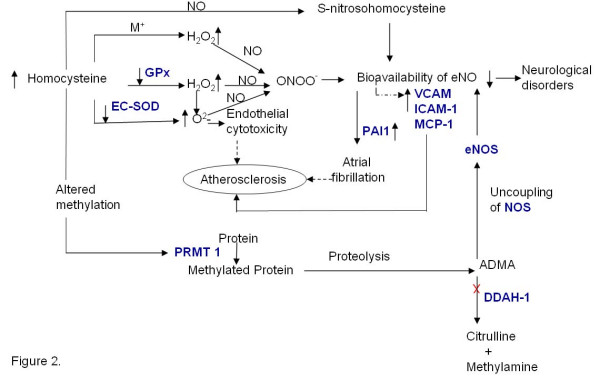
Hyperhomocysteinemia and Oxidative Stress. Homocysteine might directly or indirectly lead to oxidative stress via the pathways shown in the figure. The genes marked in blue have been identified by literature based searches as mentioned in the methods section. The solid and dotted lines indicate direct and indirect (multi step) interaction/ conversion respectively. X – Inhibition